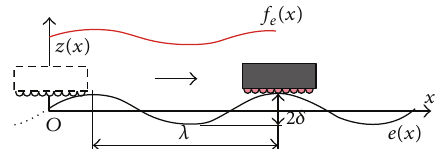
Figure 2: The reaction force of a linear motion